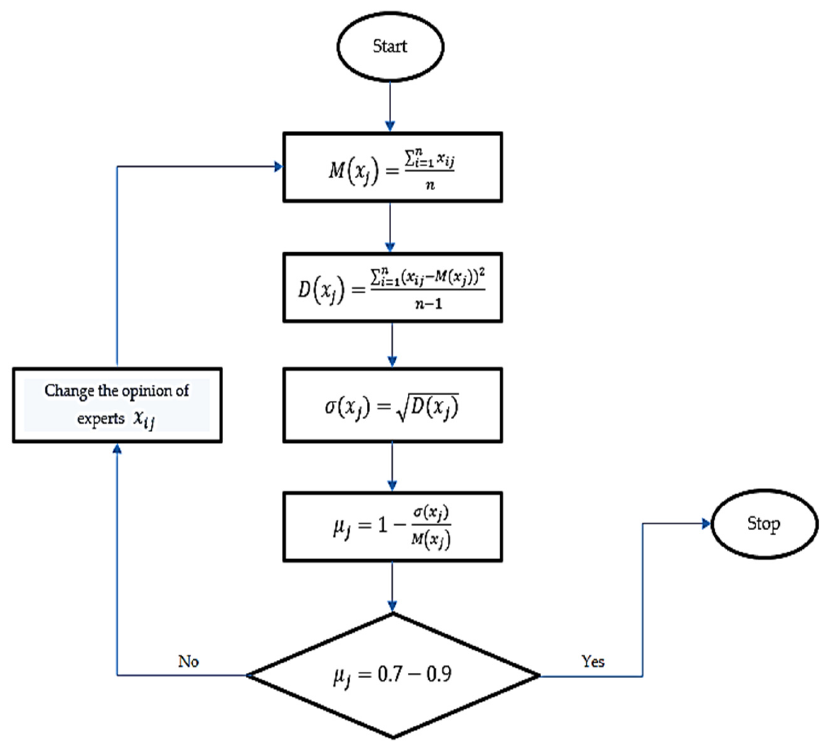
Figure 1. Flowchart of the process of the mean-square deviation method.